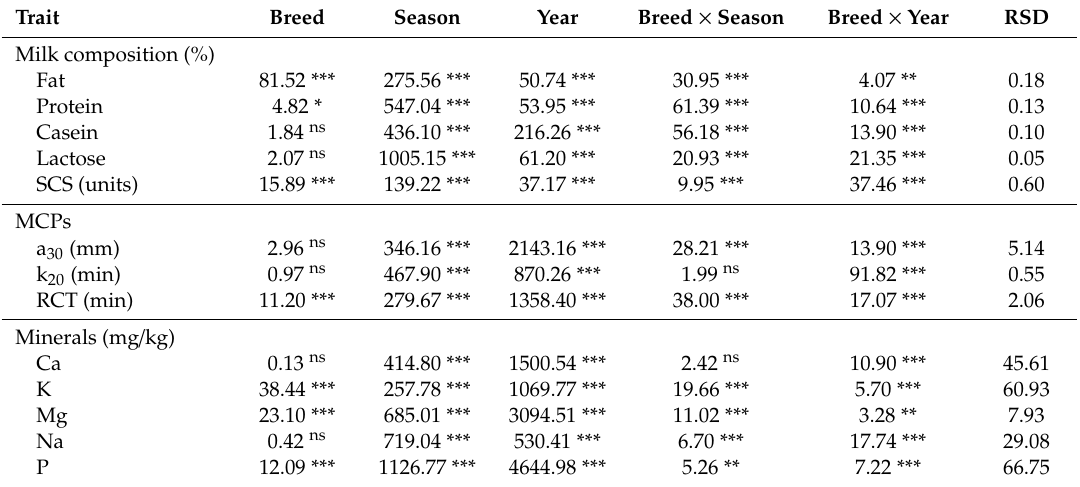
Table 3. F-value and significance of fixed e ff ects included in the analysis of variance for bulk milk traits. Trait